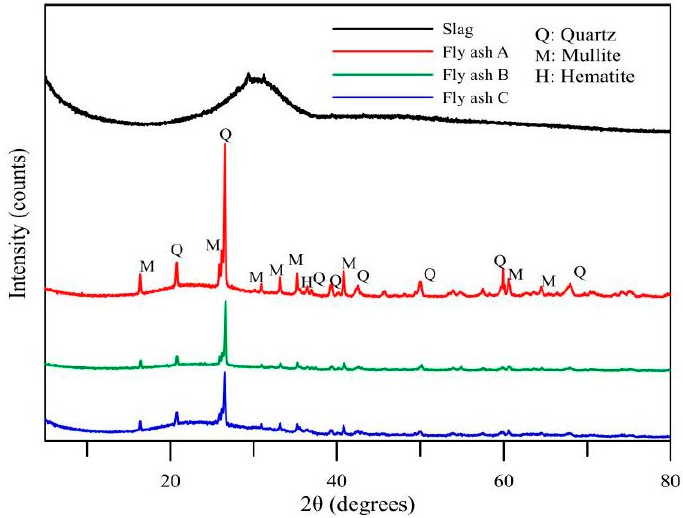
Figure 1. X-ray diffraction (XRD) patterns of fly ash and ground granulated blast-furnace slag.